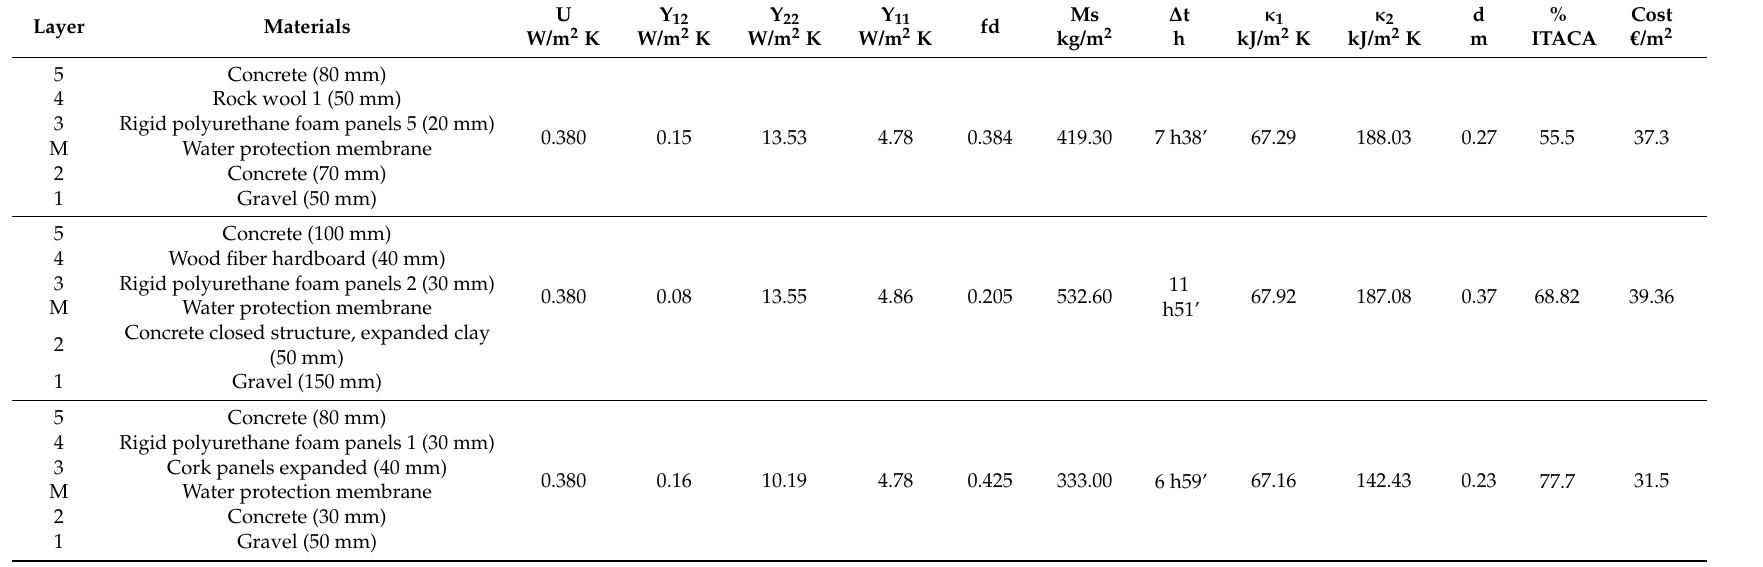
Table 10. Example of high performance slab-on-ground with concrete